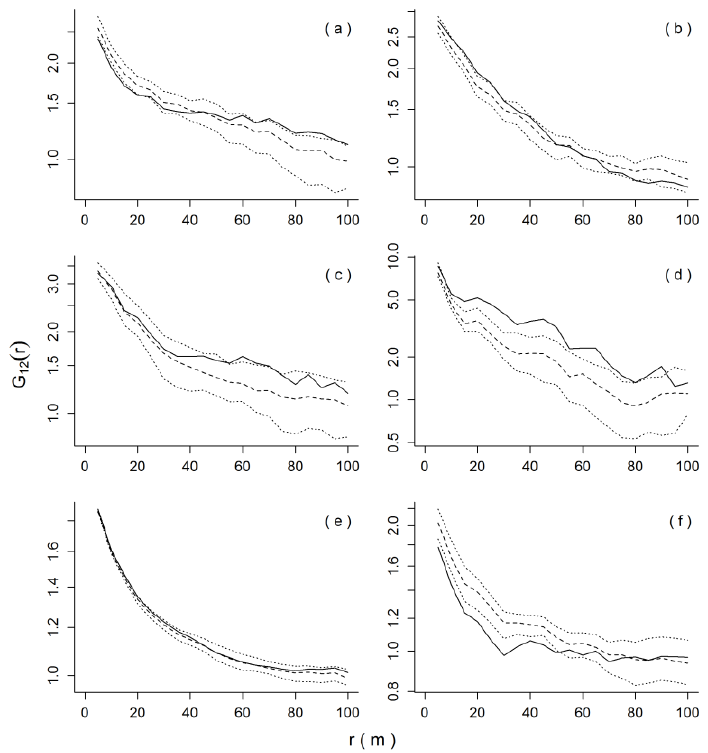
Figure 3. Examples of pair correlation functions for liana species and tree species: negative at some scales while positive at others ( a , b ), positive associations at <five scales ( c ) and at ≥ five scales ( d ), negative associations at <five scales ( e ) and ≥ five scales ( f ).